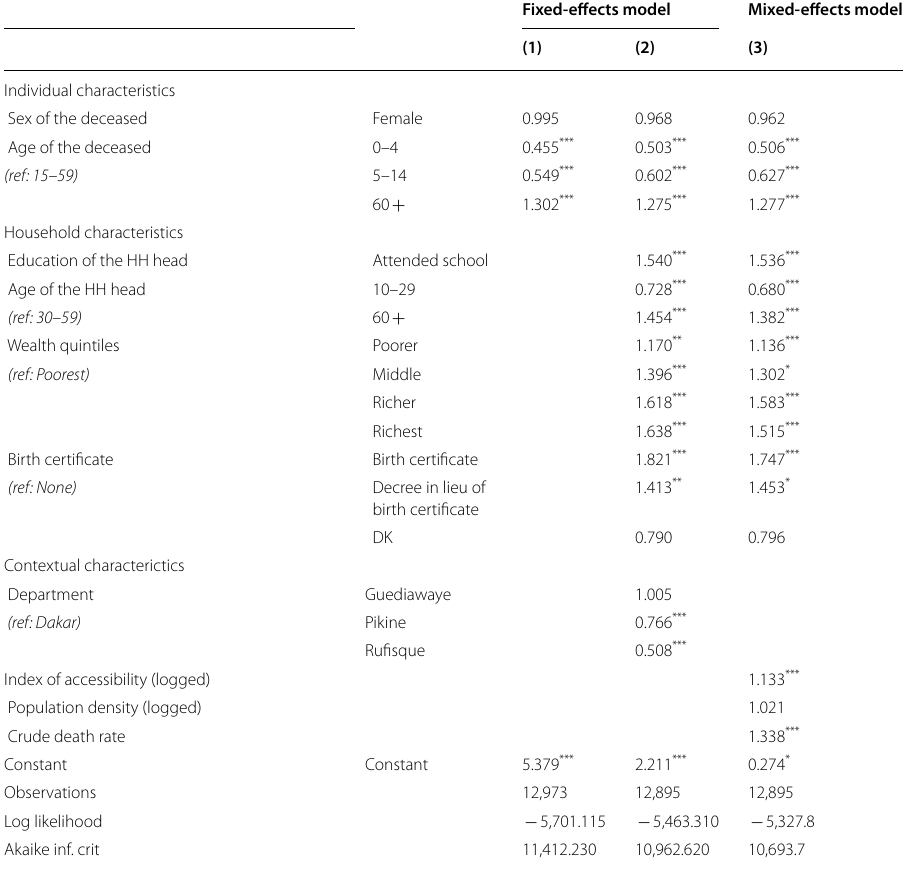
Table 4 Odds ratios from the fixed-effects and mixed-effects